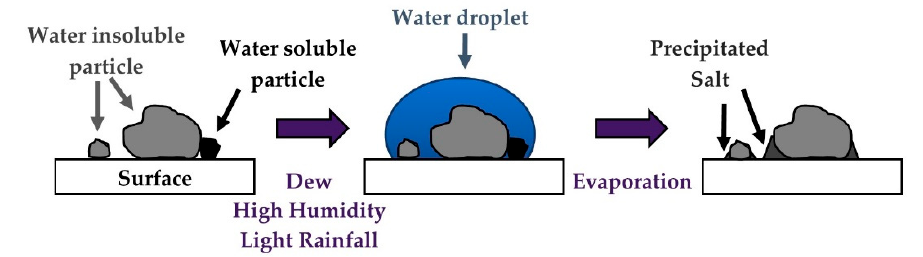
Figure 12. Illustration of the cementation process adapted from Cuddihy [20] and Ilse et al. [18].